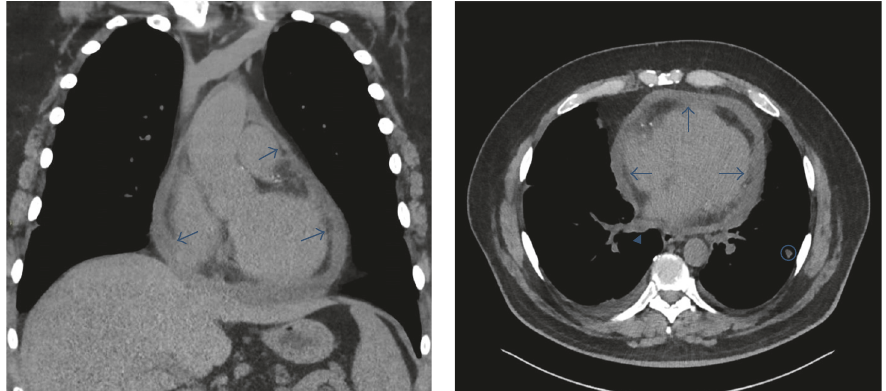
Figure 1: Chest CT imaging. Coronal view of noncontrast chest CT scan showing hyperattenuated pericardium (arrows). Axial chest CT scan showing the same diffusely thickened pericardium. Enlarged mediastinal lymph node (arrowhead). Note the solitary nodule in the Left lower lobe (encircled).